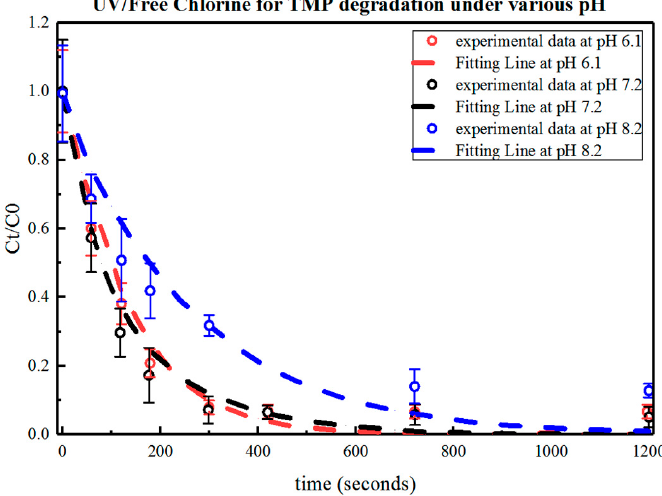
Figure 3. Fitting results for the UV/free chlorine process degradation of TMP under various pH levels. Conditions: [TMP] 0 = 0.01 mM, [free chlorine] 0 = 0.05 mM, UV light intensity = 9.45 × 10 − 7 Einstein/L s.